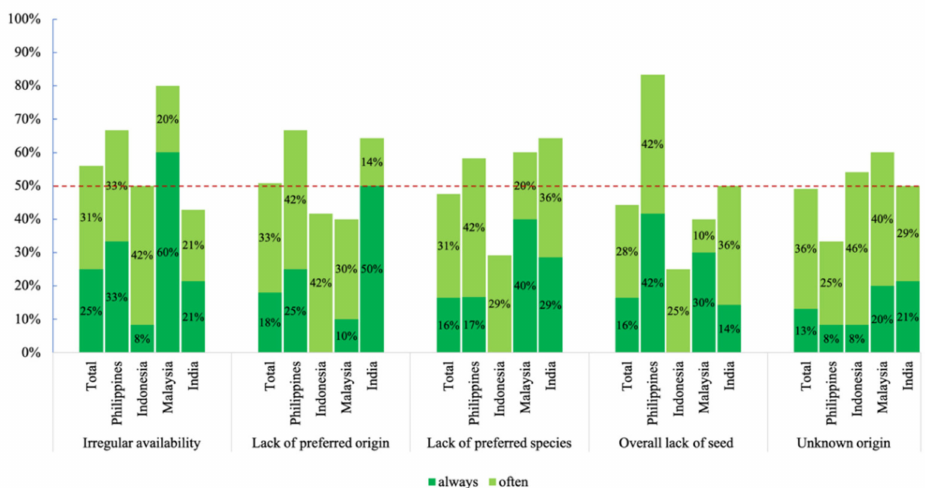
Figure 4. Challenges regarding seed quality reported by FLR practitioners (in % of projects per country, total of 61